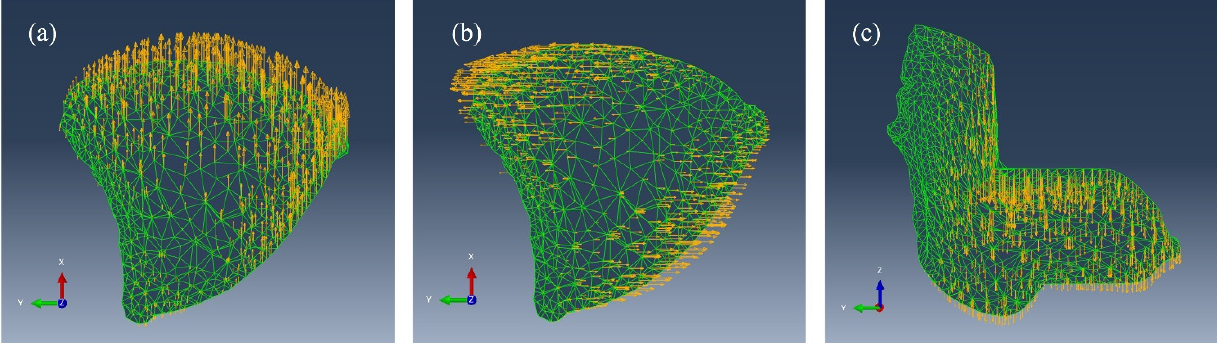
Figure 6. Node displacement of the left breast model: ( a ) medial–lateral direction and ( b ) anterior– posterior direction in the axial plane at 2 cm from the compression paddle, and ( c ) CC direction in the sagittal plane through the nipple. The length of the arrows represents the magnitude of displacement.